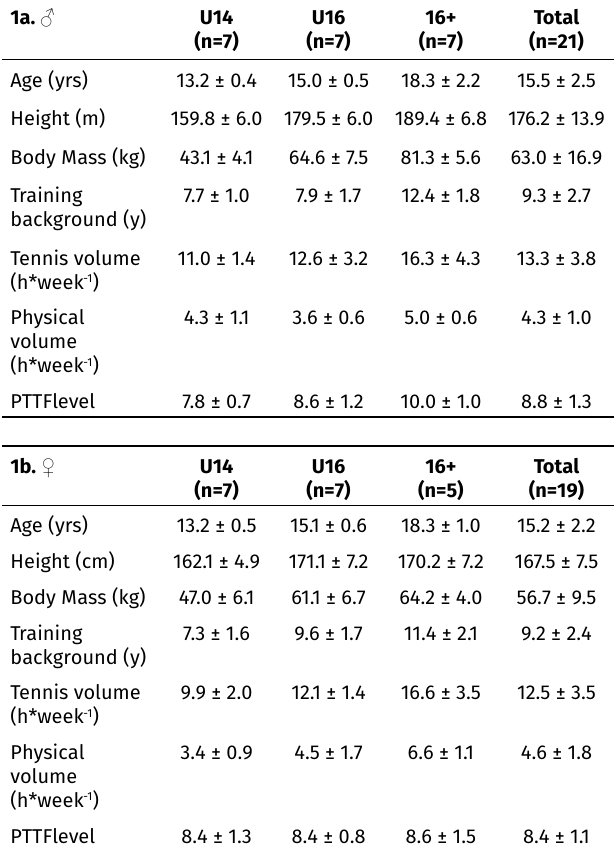
Table 1. Participants characteristics (mean ± SD) and their final